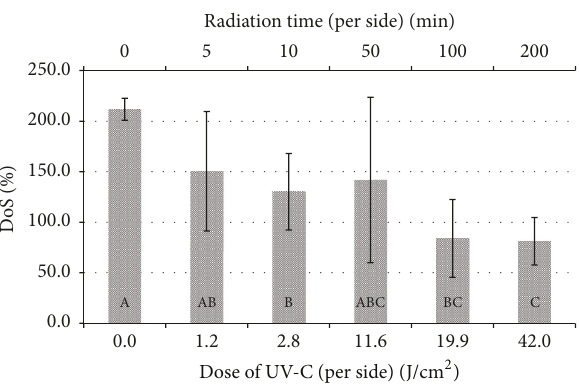
Figure 2: Degree of swelling as a function of the UV dose and the radiation time; bars with different letters are significantly different (𝑝 < 0.05)